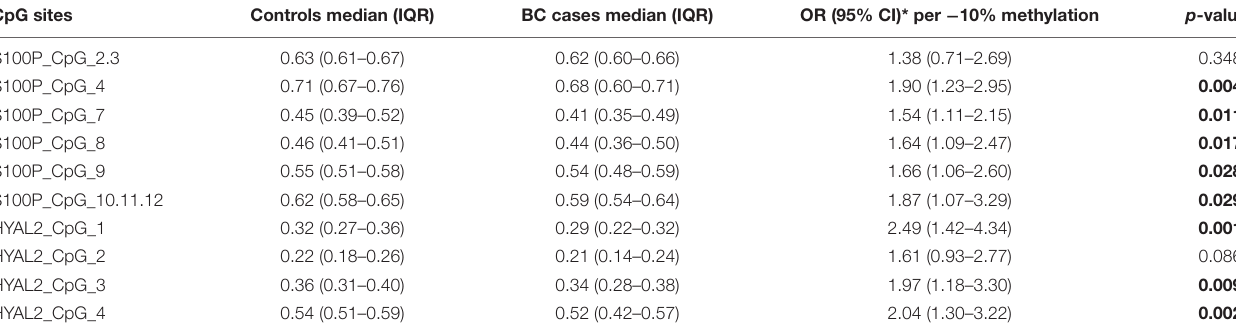
TABLE 4 | Methylation differences of S100P and HYAL2 between BC cases and controls in Study II. CpG sites Controls median